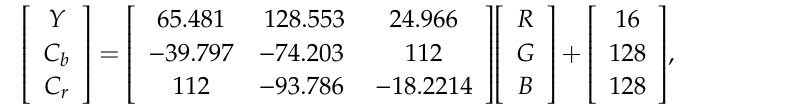
where I ( x is the luminance pixel value at image location ( x , y ) over time ( t ) from image sequences, , y , t ) and | ROI | is the size of the selected